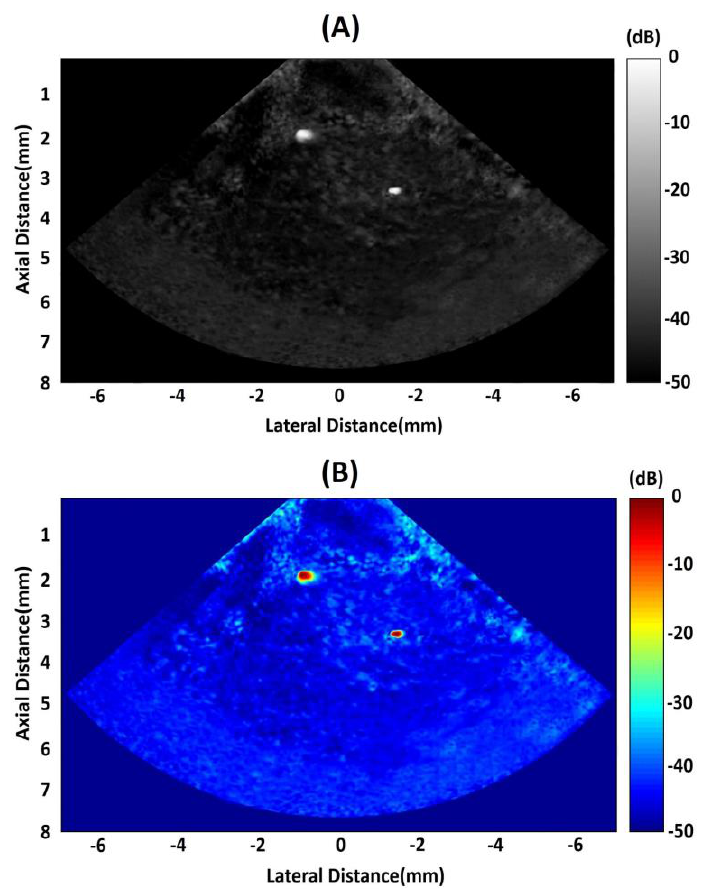
Figure 12. ( A ) Copper wires phantom image. ( B ) Pseudo-color image of copper wires phantom.